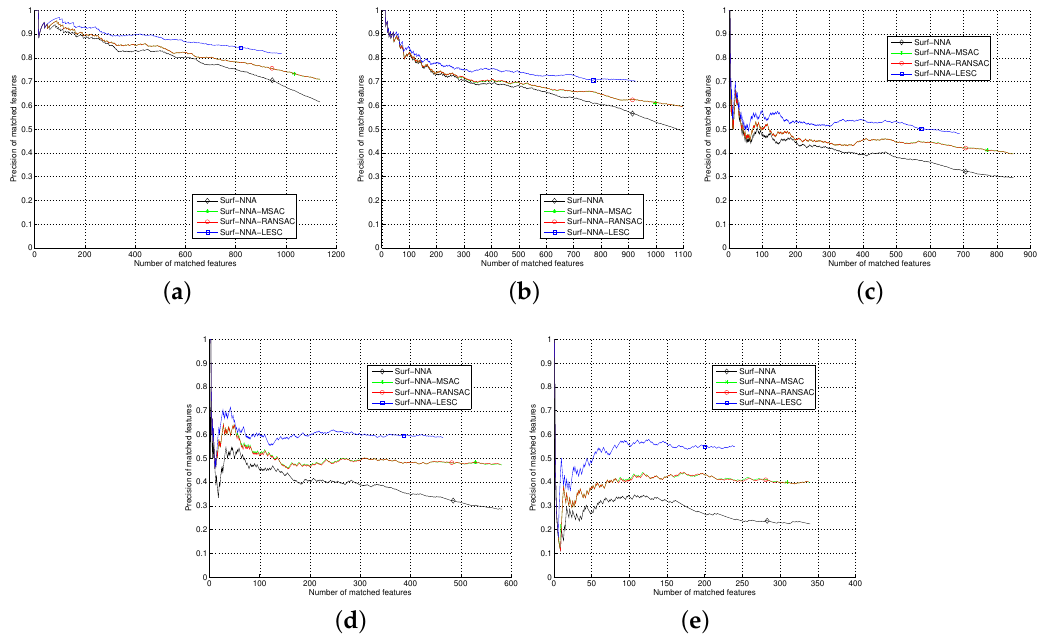
Figure 4. Blur for the textured scene by the Trees sequence. From ( a ) to ( e ) the degree of change ascends.